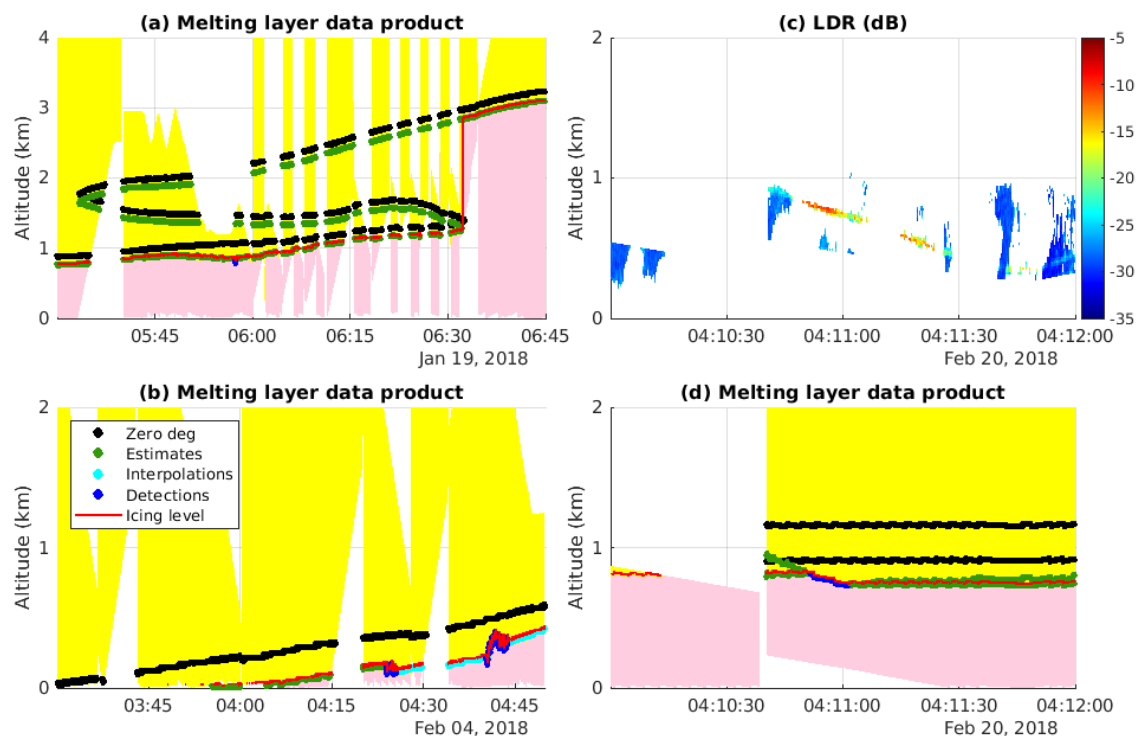
Figure 4. Melting layer product for ( a ) a situation where the flight pattern intersects several melting layers, ( b ) a situation where the melting layer intersects the surface. ( c , d ) LDR and the melting layer data product for a case where the back-lobe filter did not capture all of the back-lobe data (see text for details). Colors in ( a , b , d ) as in Figure 3b. Times are in UTC.